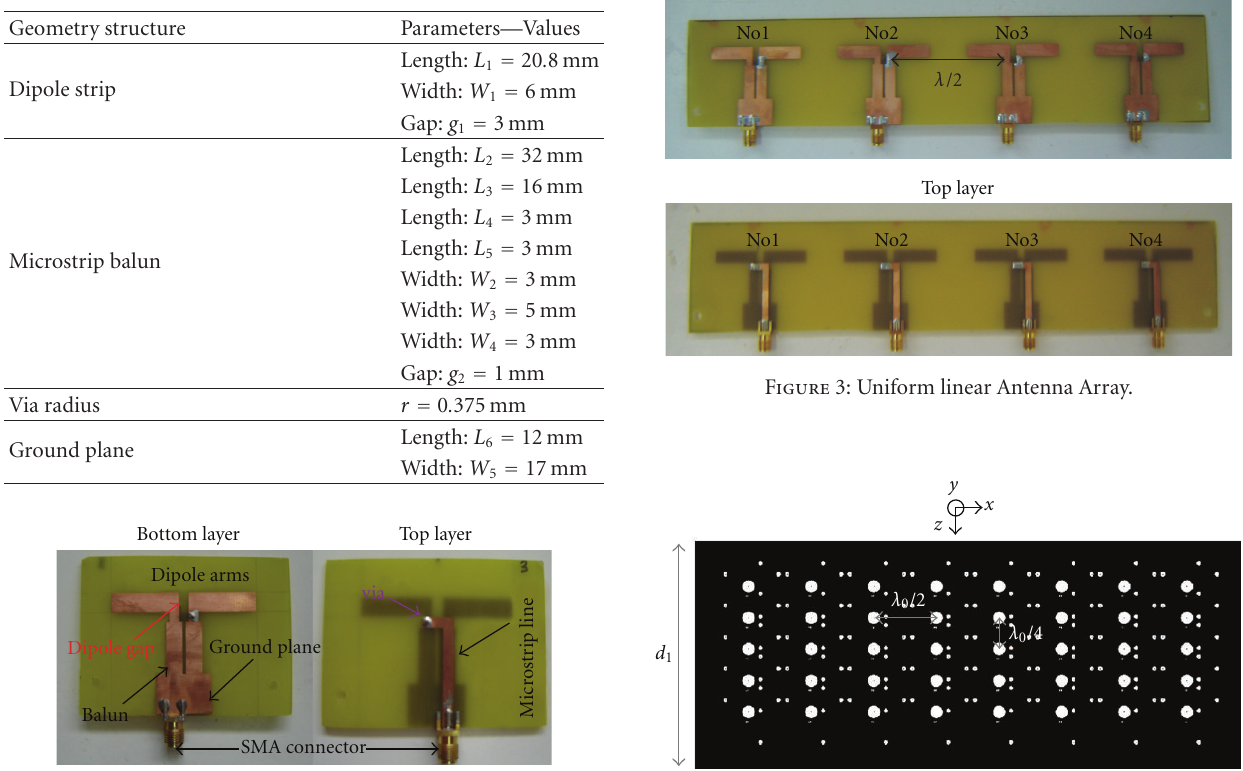
Table 1: Printed dipole dimensions.